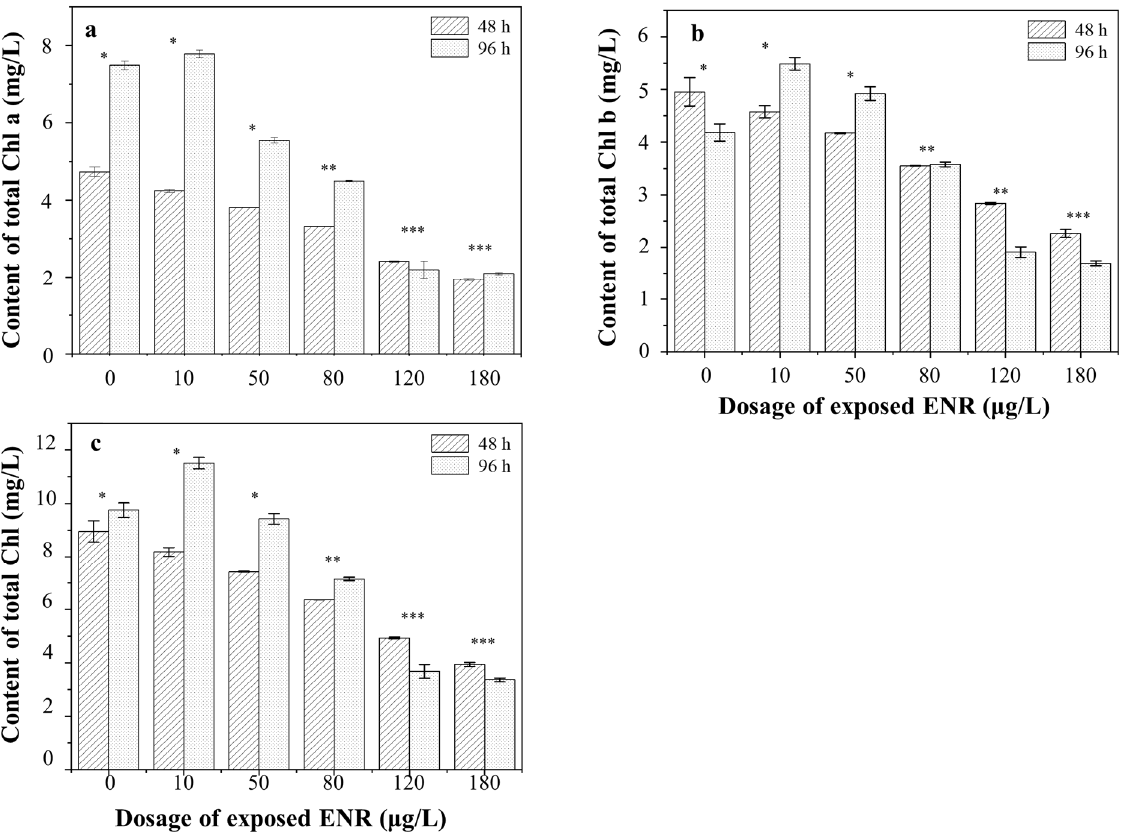
Figure 4. The chlorophyll contents in algae under different exposure dosages of ENR. ( a ) Chl a content; ( b ) Chl b content; ( c ) Total Chl content. The number of “*” was referred as the significant between-group variance. The same number means no significant difference, whereas the different number means the significant difference.